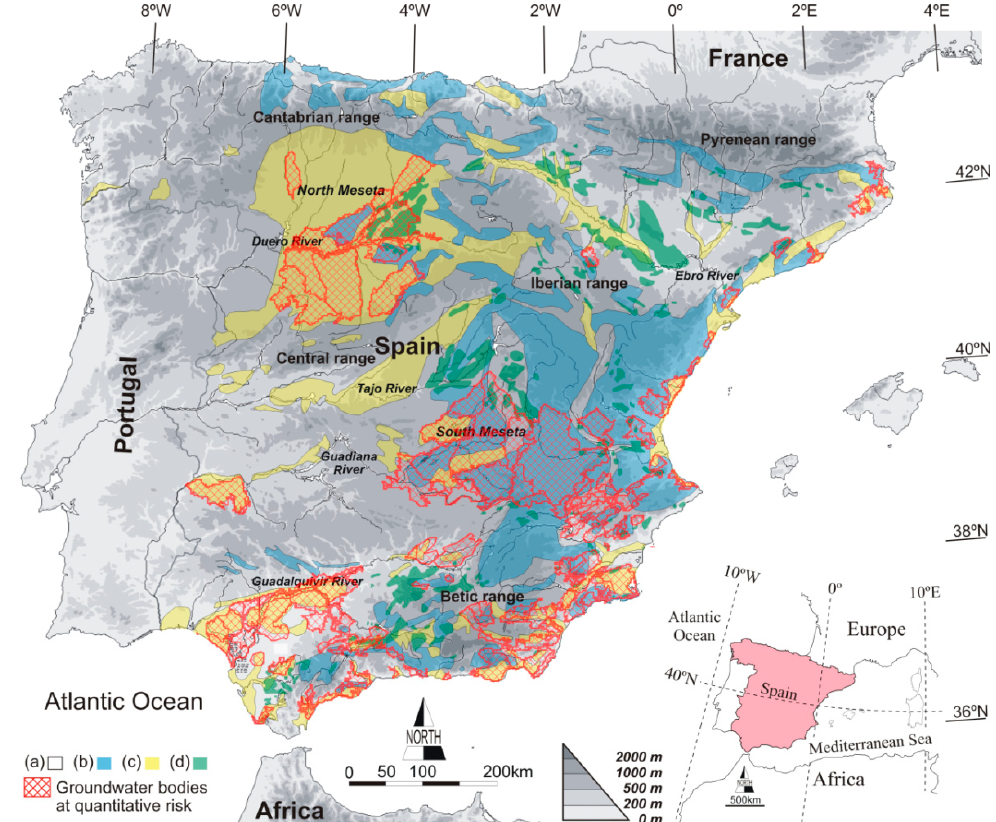
Figure 2. Map of continental Spain, showing the 146 Spanish GW bodies at quantitative risk of not fulfilling the Water Framework Directive (WFD) [14] (2000) objectives (red shadowed areas), the main mountain ranges and hydrographic basins, and the hydrogeological behavior of geological materials forming the GW bodies according to permeability type [37], modified from [31] as: ( a ) low to moderate permeability pre-Triassic metamorphic rocks, granitic outcrops, and Triassic to Miocene marly sedimentary formations; ( b ) moderate to high permeability Paleozoic to Tertiary; ( c ) moderate to high permeability Pleo-Quaternary detritic; and ( d ) Triassic to Miocene evaporitic outcrops.